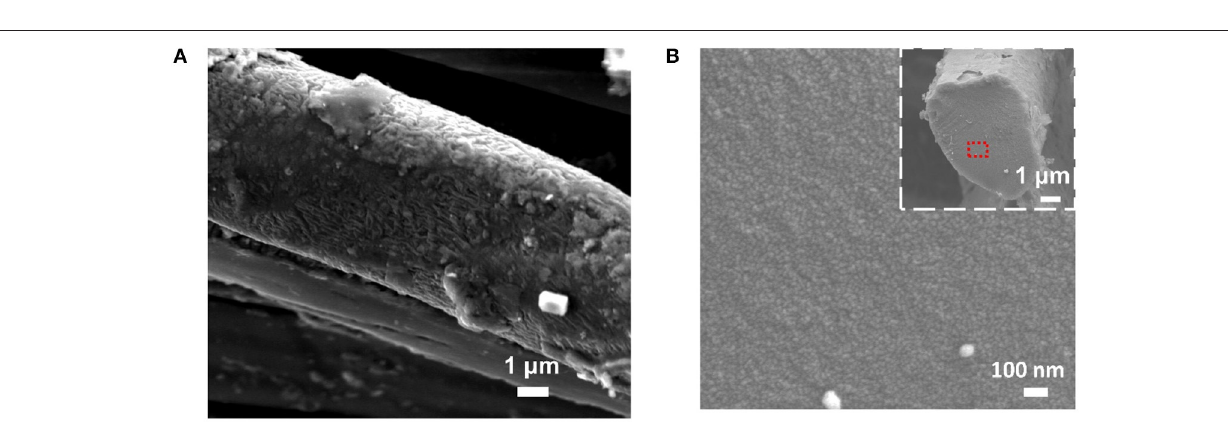
FIGURE 3 | (A) SEM image of CBSs with the carbonization temperature of 1,000 ◦ C; and (B) Cross section image of CBSs and zoomed cross section image of CBSs with the carbonization temperature of 1,000 ◦